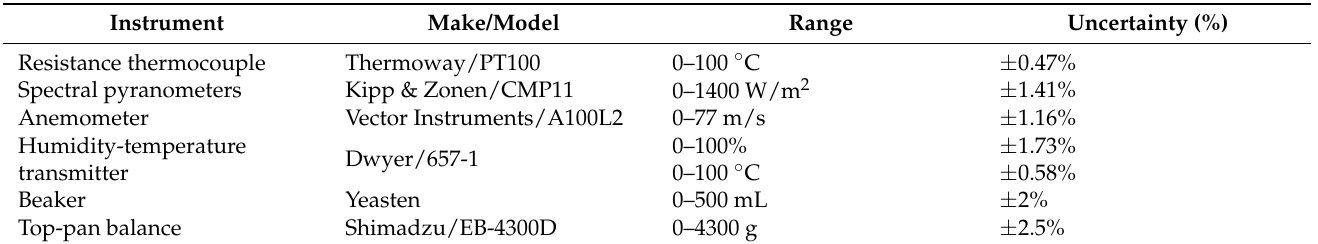
Table 2. The uncertainty, range, make, and model of the measuring instruments used.